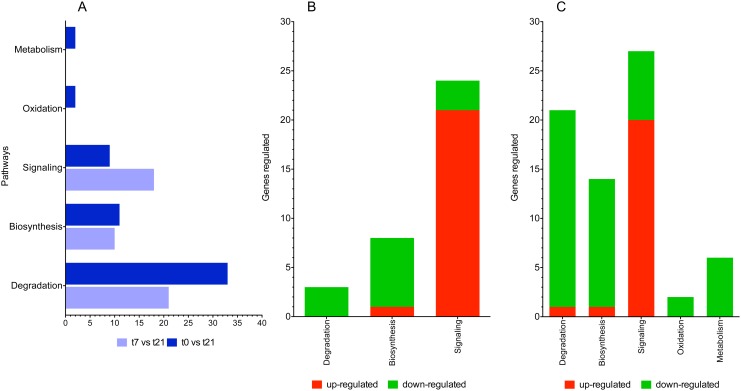
Representative canonical pathways study using the ingenuity pathway analysis (IPA) tool.(A) A comparison of the numbers of pathways that are statistically significant is shown for each point (t7 vs t21 and t0 vs t21). (B) The numbers of genes that are differentially expressed in each of the pathways are depicted for t7 vs t21 and (C) t0 vs t21. Down-regulation is shown in green and up-regulation in red.